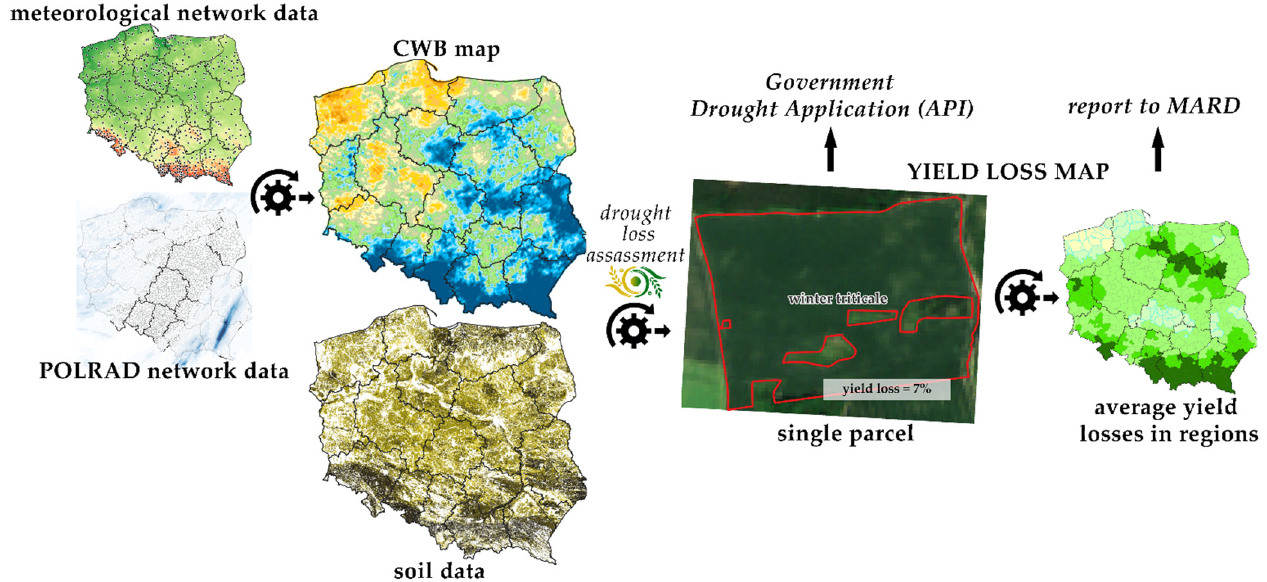
Figure 2. Flowchart of the development process for generating yield loss maps in the Agricultural Drought Monitoring System (ADMS). Source: own study (IUNG-PIB).